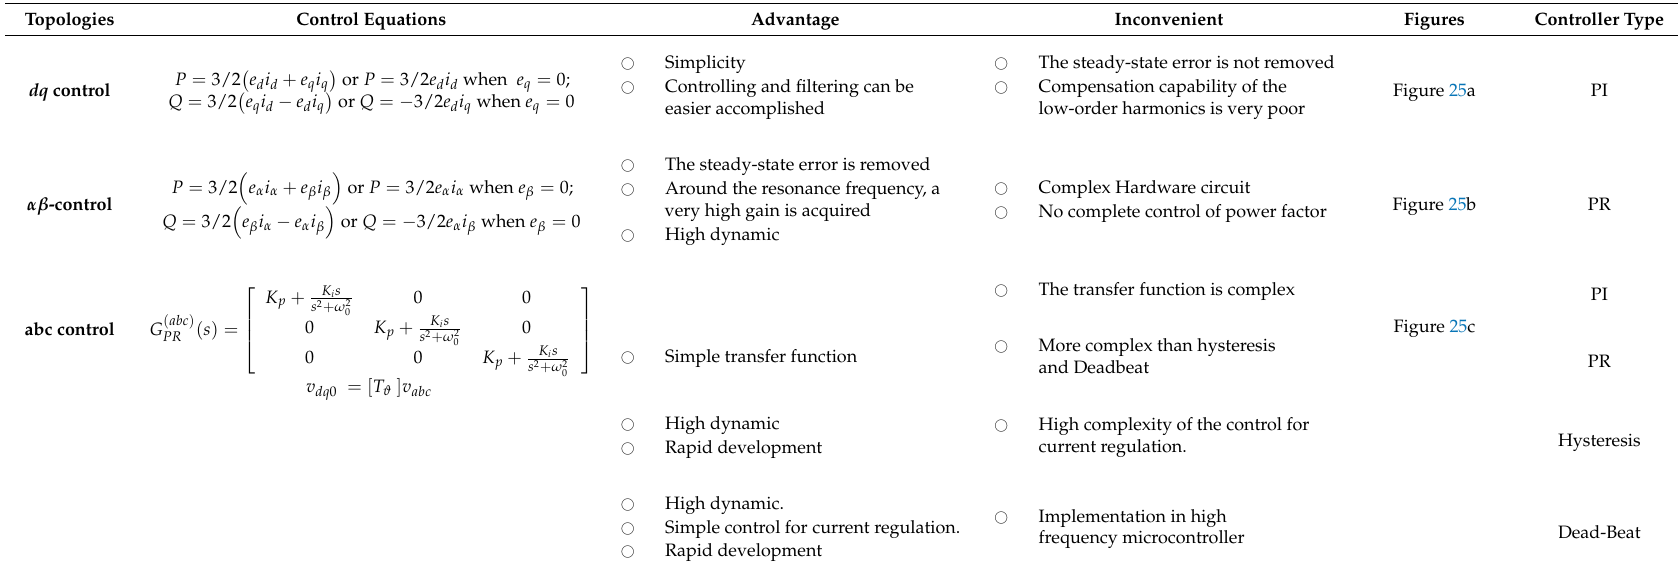
Table 5. Control structures for three-phase inverters